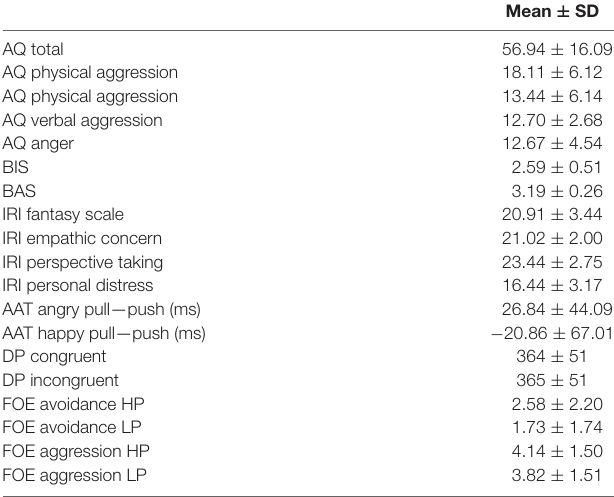
TABLE 2 | Descriptive statistics for questionnaires and computerized measures in Experiment 2 ( n = 34).